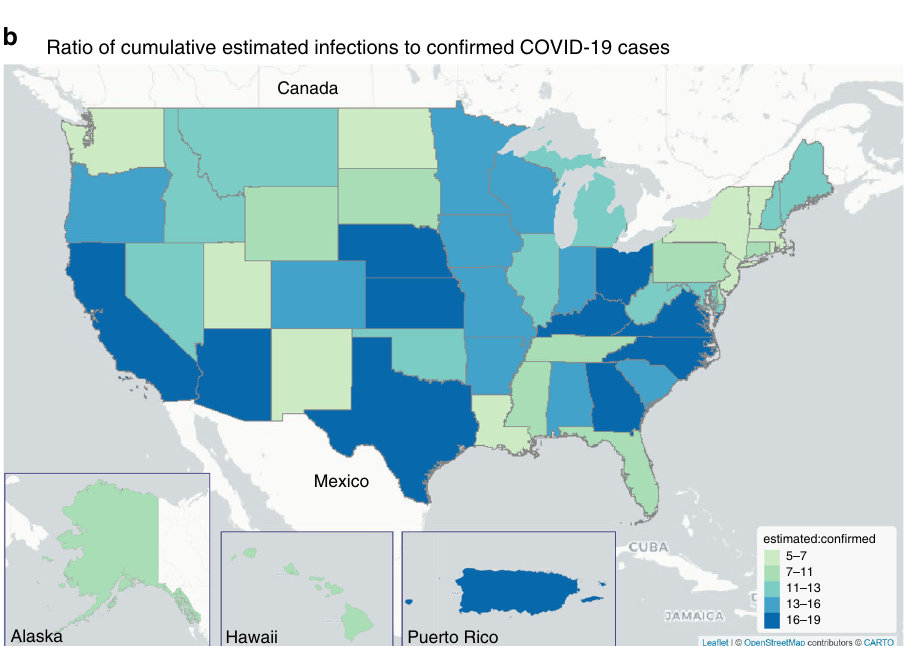
Fig. 3 Map of con fi rmed COVID-19 case counts and the ratio of expected infections. Con fi rmed COVID-19 cases per 1000 and estimated SARS-CoV-2 infections per 1000 varied by US state and region. Map of con fi rmed COVID-19 case counts and the ratio of expected infections. Each panel displays colors de fi ned by quintiles of the distribution of a con fi rmed COVID-19 cases per 1000 and b the ratio of the median of the distribution of estimated infections from the probabilistic bias analysis to con fi rmed COVID-19 cases. Analyses include cumulative con fi rmed COVID-19 case counts up to April 18, 2020. Estimated infections were from a using semi-Bayesian probabilistic bias analysis to correct for incomplete testing and imperfect test accuracy. Estimated SARS-CoV-2 infections include both symptomatic and asymptomatic infections. Quality of daily estimates of the number of tests performed varied by state; see Supplementary Table 3 for details. Underlying map from OpenStreetMap available under the Open Database License (https://www. openstreetmap.org/copyright). See interactive plot at